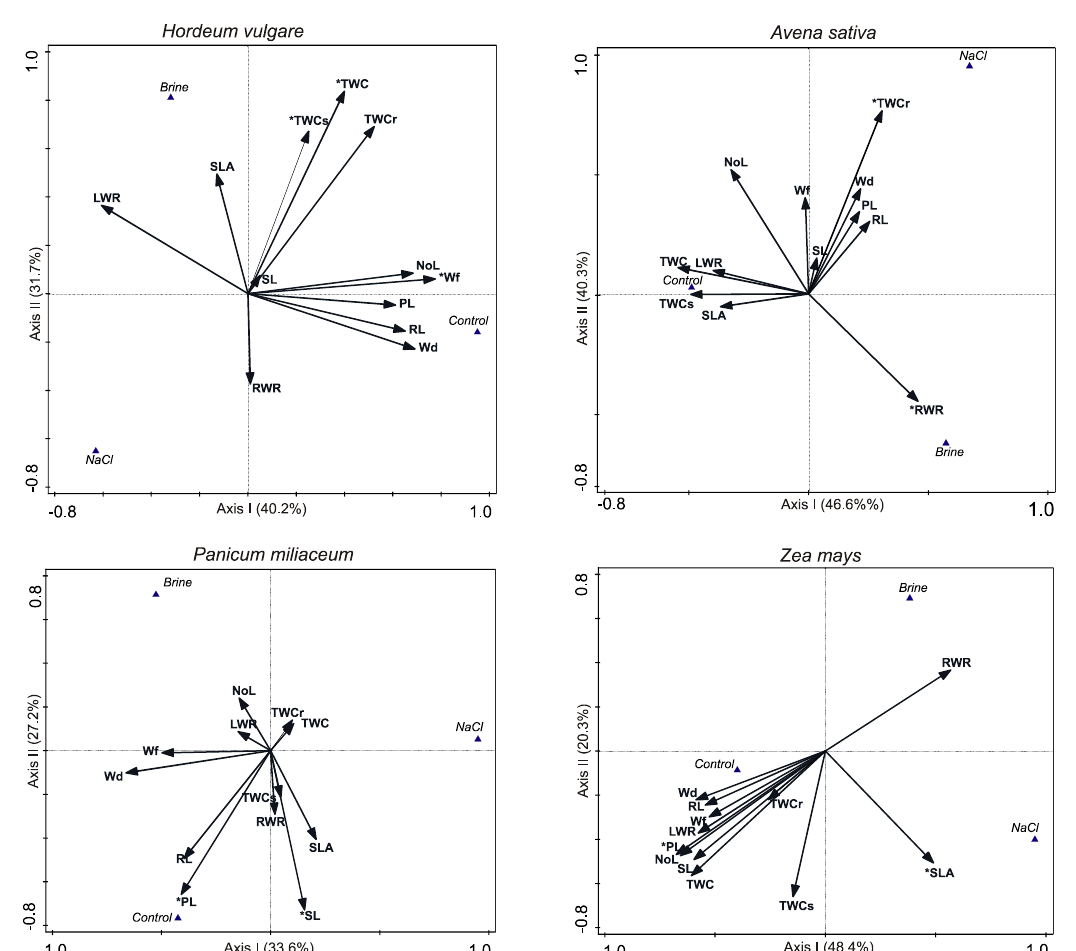
Figure 3. Results of discriminant analysis between control brine and NaCl treatments. Significant traits in group discrimination are denoted by an asterisk * ( p < 0.05). Abbreviations as in Table 2.